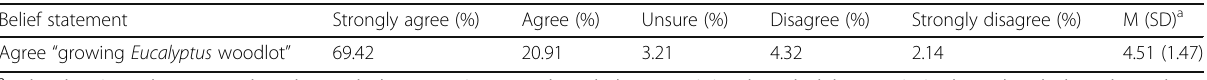
Table 4 Descriptive result for item measuring local people ’ s attitudes towards growing Eucalyptus woodlot in Gudo Beret Kebele Belief statement